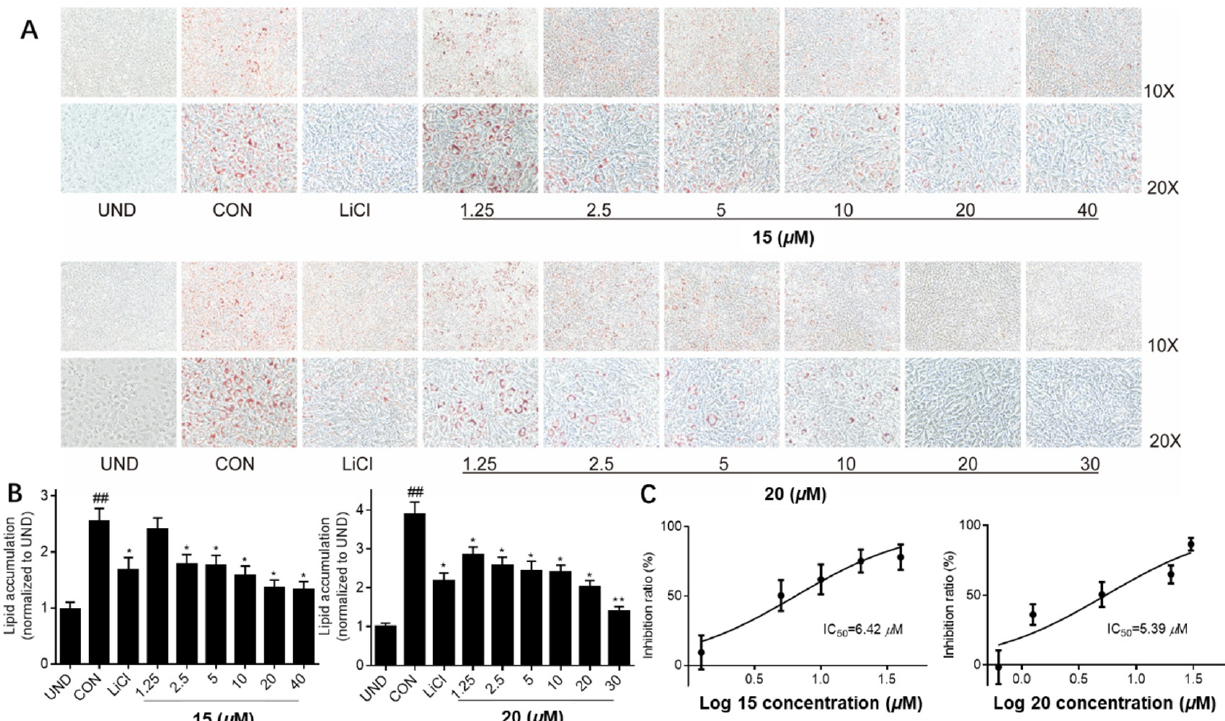
Figure 5. Effects of compounds 15 and 20 on lipid accumulation in 3T3-L1 adipocytes. ( A ) Oil Red O staining of cells administrated with serial doses of compounds 15 and 20 . ( B ) Quantification of intracellular lipid in Oil Red O-stained adipocytes. (C) The IC 50 values of compounds 15 and 20 . LiCl (20 mM) was used as a positive control. Data are representative results from three independent experi- ments. Data are shown as mean ± SD ( n = 3), (##) p < 0.01 versus undifferentiated cells (UND). (*) p < 0.05 and (**) p < 0.01 versus fully differentiated cells